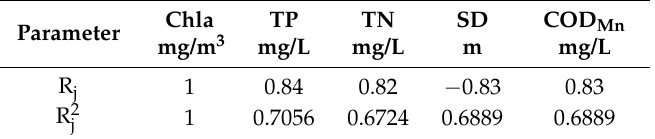
Table 1. The correlation between Partial parameters and Chla on Lakes (reservoirs) of China. Chla TP TN Parameter mg/m 3 mg/L